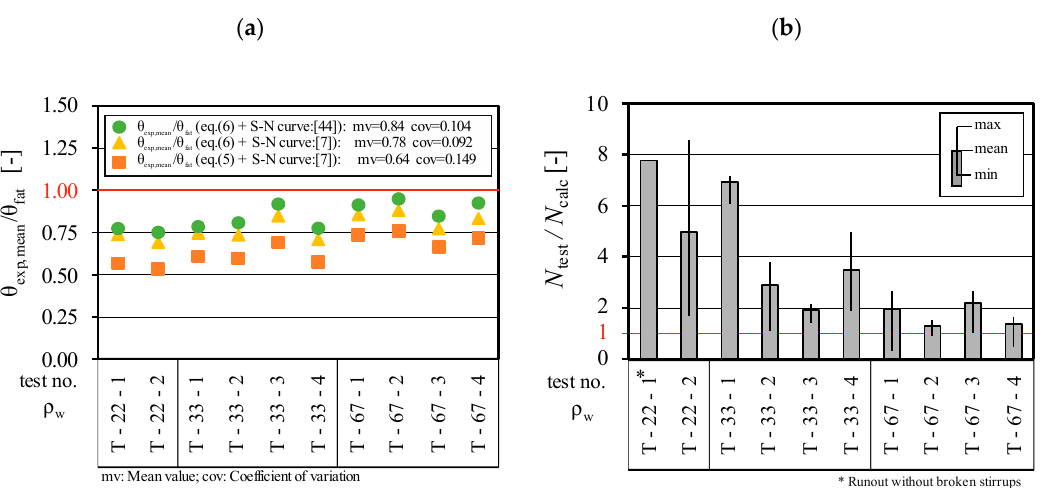
Figure 12. ( a ) Comparison of experimentally determined strut angles θ exp,mean with θ fat . ( b ) Ratio N test / N calc applying the strut inclination of Equation (6) and the S–N curve according to [45].